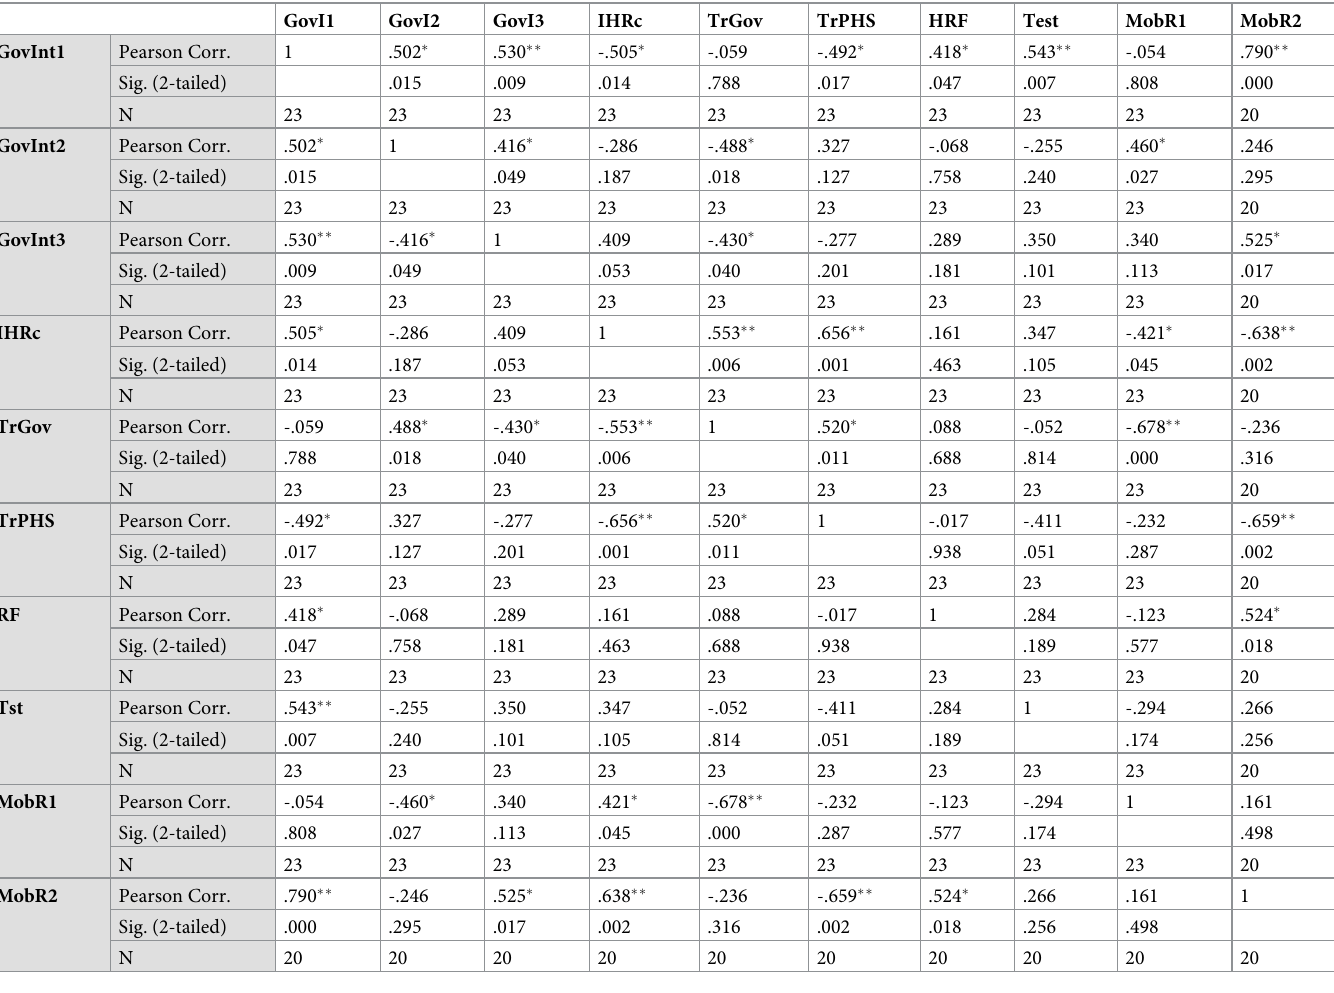
Table 4. Correlation